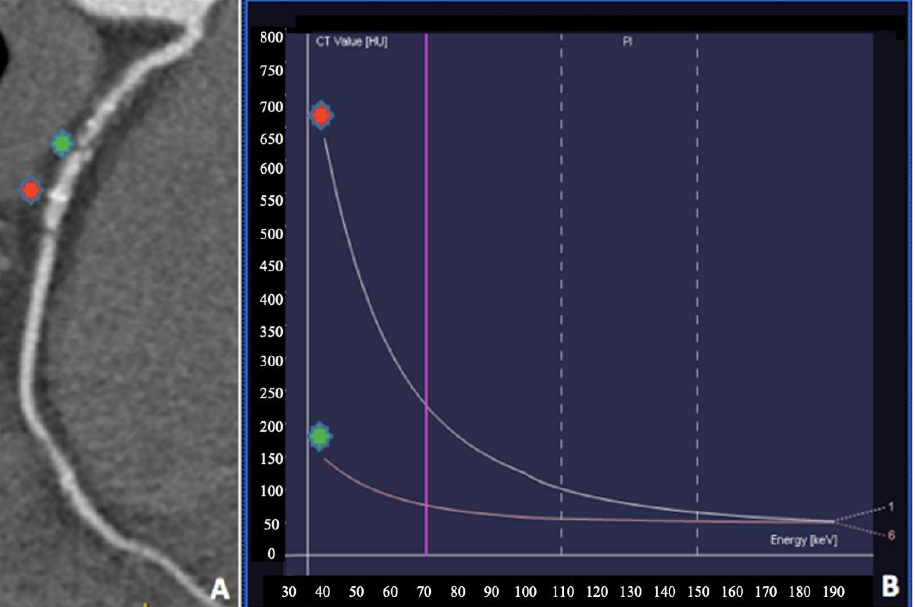
Figure 6. Coronary dual-source DECT in a 65-year-old man presenting with chest pain. ( A ) Automatically generated curved multiplanar reformation of the right coronary artery demonstrates greater than 75% stenosis (green asterisk). ( B ) Plaque analysis using monochromatic coronary reconstruction showing a clear separation of quantitative values (HU) at low keV (red asterisk: calcific plaque; green asterisk: fibrous plaque).